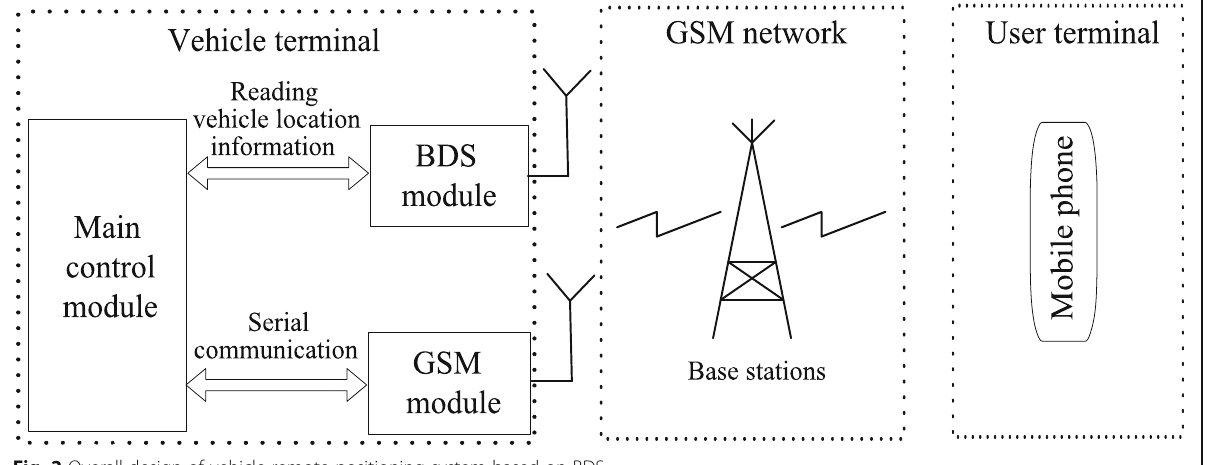
Fig. 2 Overall design of vehicle remote positioning system based on